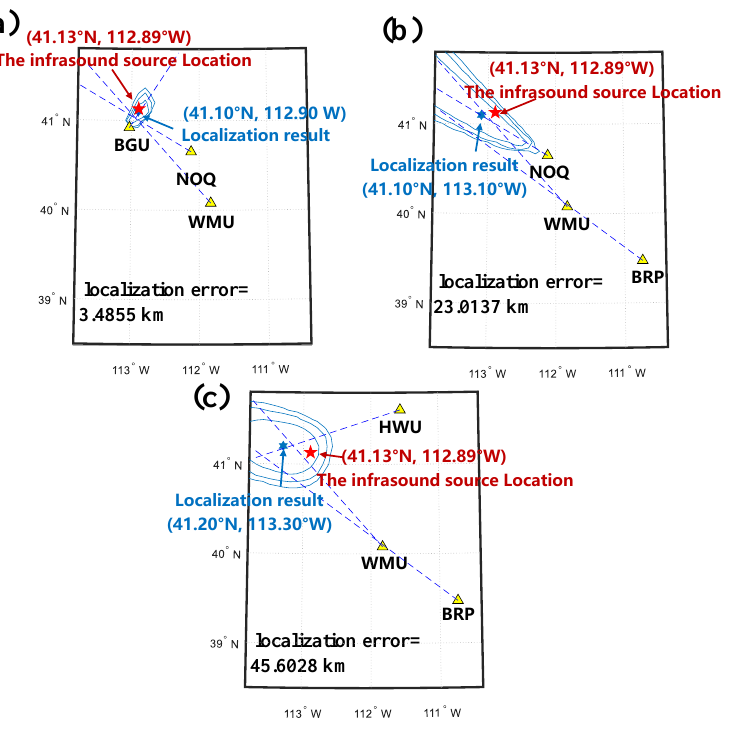
Figure 17. The influence of the distance between the station and the infrasound source on the error of localization result (arrival azimuth estimation results from the SBL algorithm); ( a ) the sum of the distances from the BGU, NOQ, and WMU stations to the infrasound source is 295.1944 km; ( b ) the sum of the distances from the BRP, NOQ, and WMU stations to the infrasound source is 569.0806 km; and ( c ) the sum of the distances from BRP, HWU, and WMU stations to the infrasound source is 624.5797